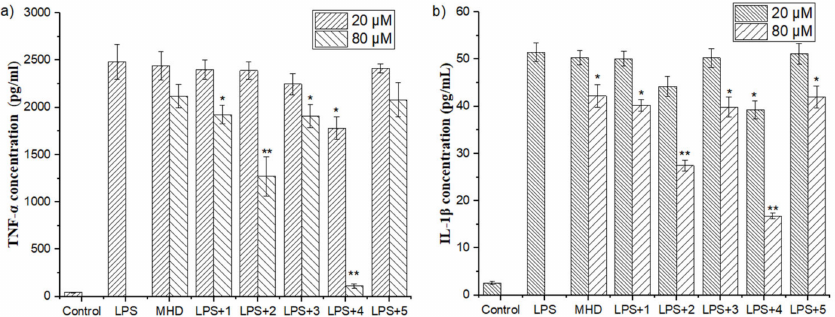
Figure 4. ( a ) The effect of 1-methylhydantoin cinnamic imides on the secretion of TNF- α in RAW264.7 cells induced by LPS. ( b ) The effect of 1-methylhydantoin cinnamic imides on the secretion of IL-1 β in RAW264.7 cells induced by LPS. (n = 3, * p < 0.05, ** p < 0.01 vs. the LPS-treated group).